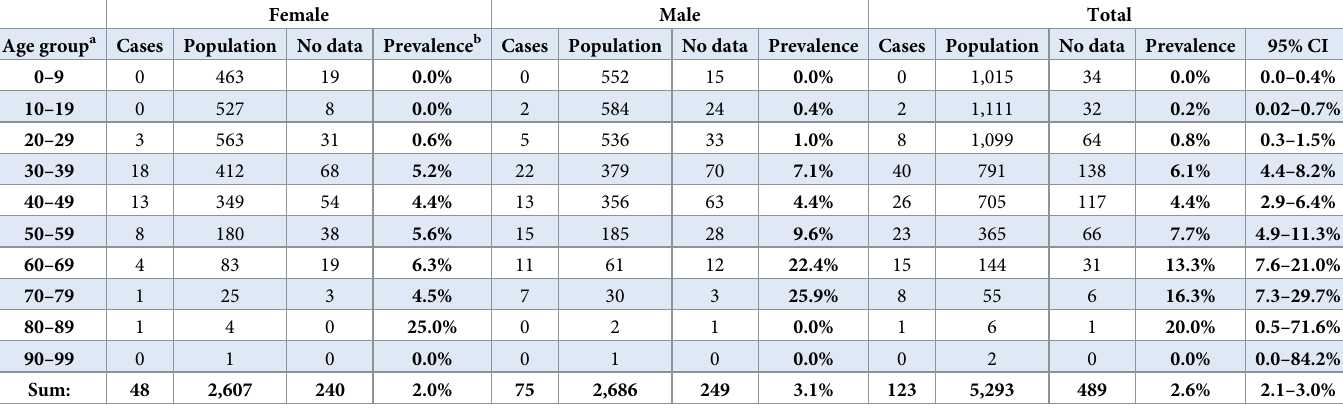
Table 5. People living with chronic hepatitis B, by age group and sex, in five remote communities in the